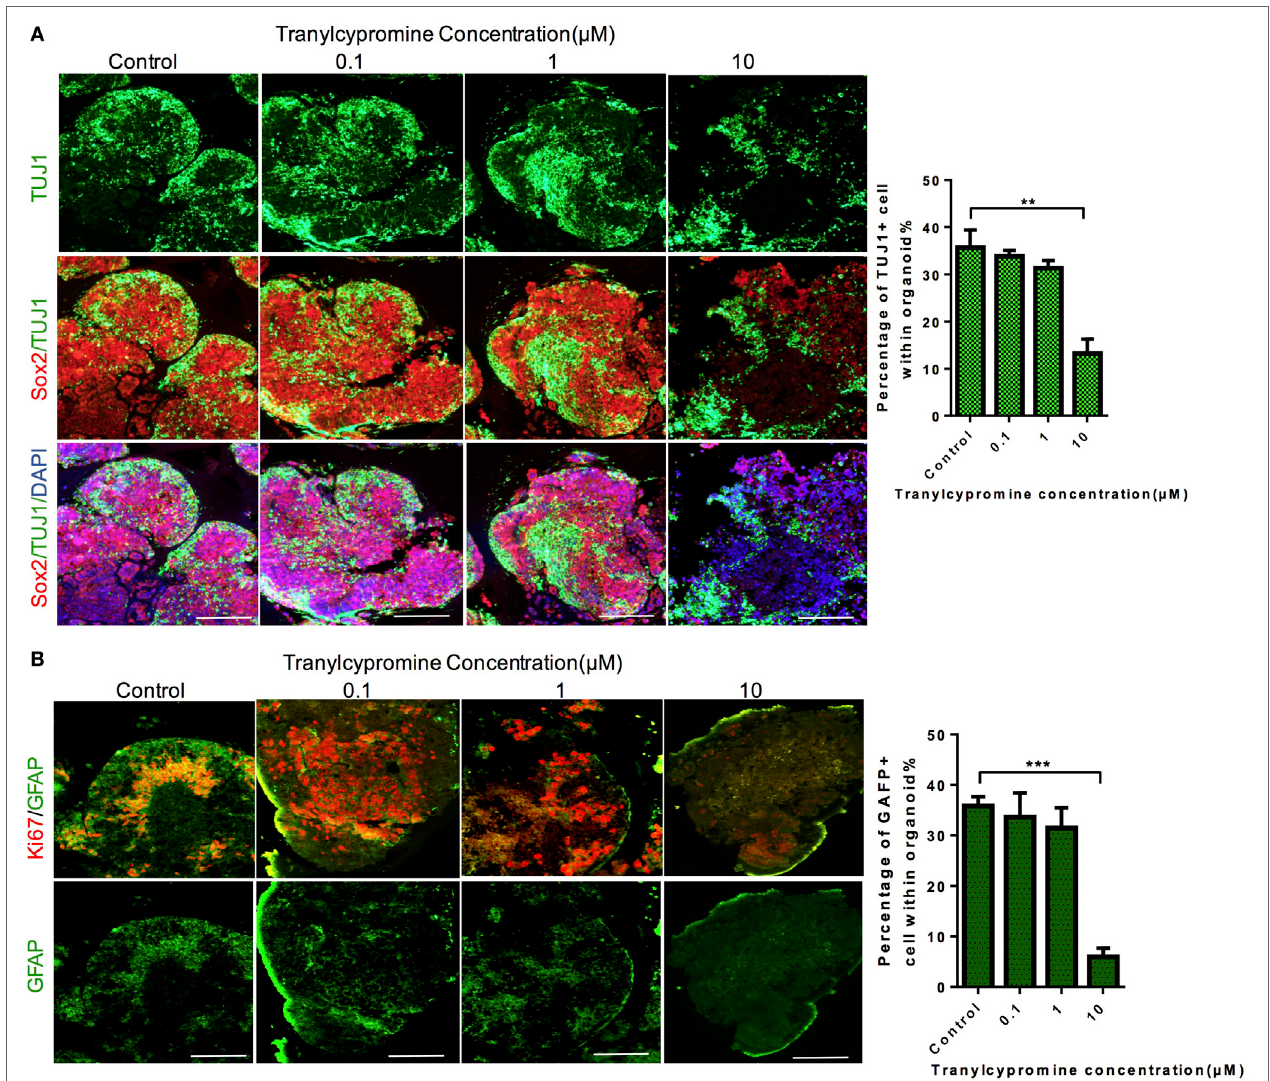
FigUre 4 | Tranylcypromine treatment impaired neuron and astrocyte of brain organoid. (a,B) Immunostaining for the neural progenitor marker Sox2, astrocyte marker GFAP, and neuron marker TUJ1 in human cerebral organoids after treatment with different concentrations of tranylcypromine. Scale bars: 200